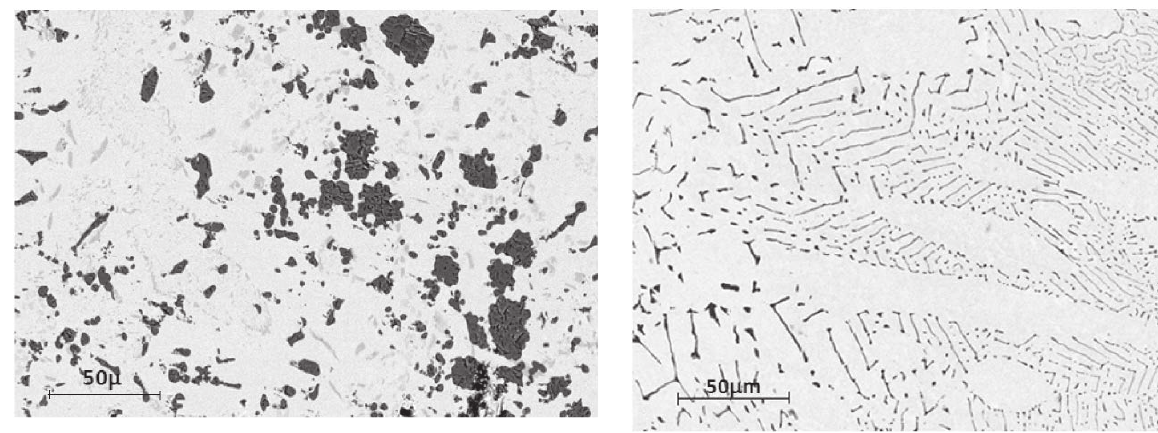
Fig. 10: SEM-BSE image showing TiC particles (both small spherical and bigger angular) in the alloy droplet from experiment 9 FeCr23 (10 min)